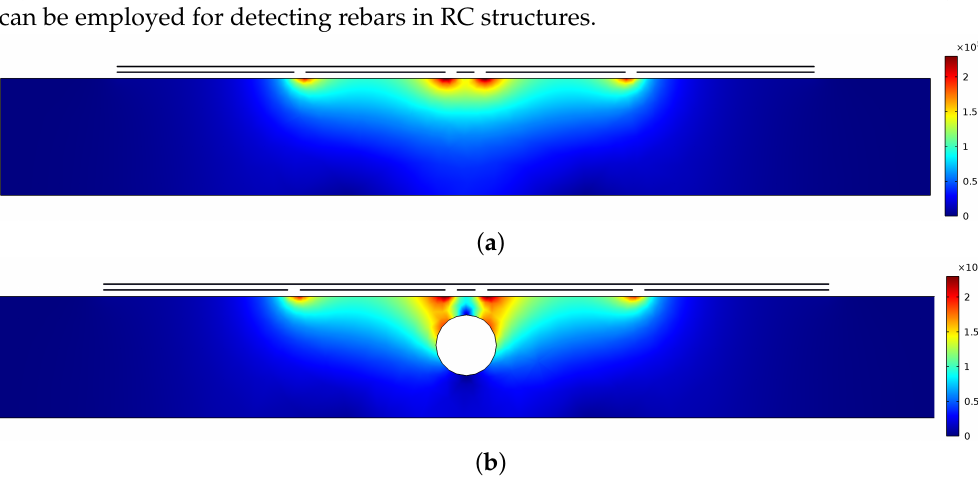
Figure 5. Surface plot of the electric field distribution (V/m) for a concrete slab in xz plane: ( a ) sound sample, ( b ) a concrete slab with